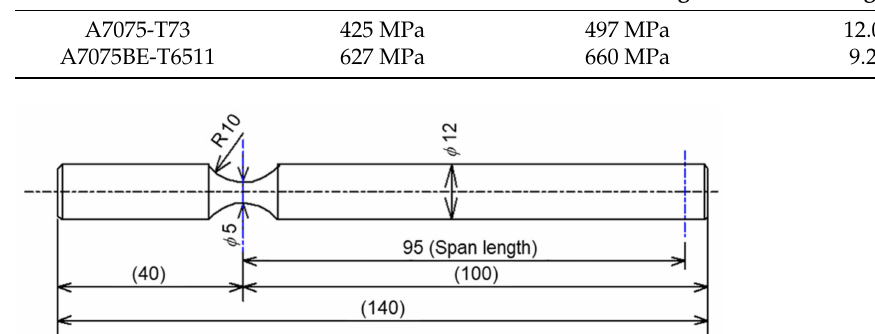
Figure 1. Shape and dimensions of the A7075BE-T6511 fatigue